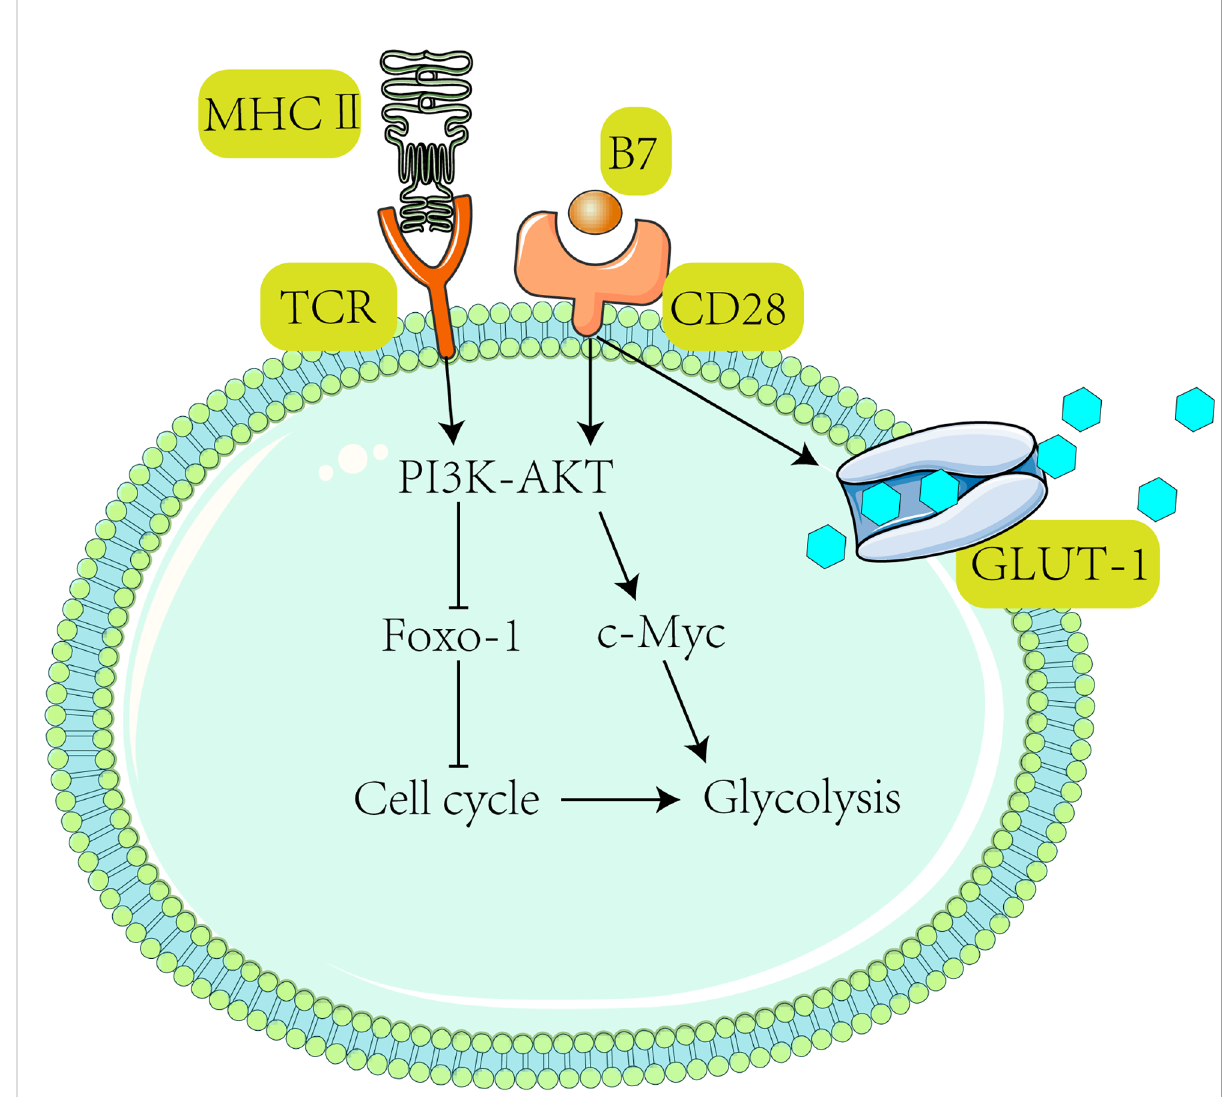
FIGURE 3 Activation of T cells requires receiving TCR and CD28-mediated co-stimulation, subsequently activating the PI3K-Akt pathway (47). After the PI3K-Akt pathway activates c-Myc, downstream Glut1 expression is stimulated to promote glycolysis (139) and T cell proliferation (146). It has been shown that activated T cells drive the PI3K-Akt-Foxo1 regulatory circuit (147, 148). Foxo1 (Forkhead box P1) is a transcriptional repressor of the T cell activation (147). Activation of AKT suppresses Foxo1 expression (149) and ultimately promotes T cell activation